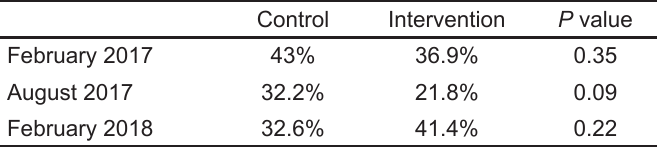
Table 2. Percentage positive depression screens.